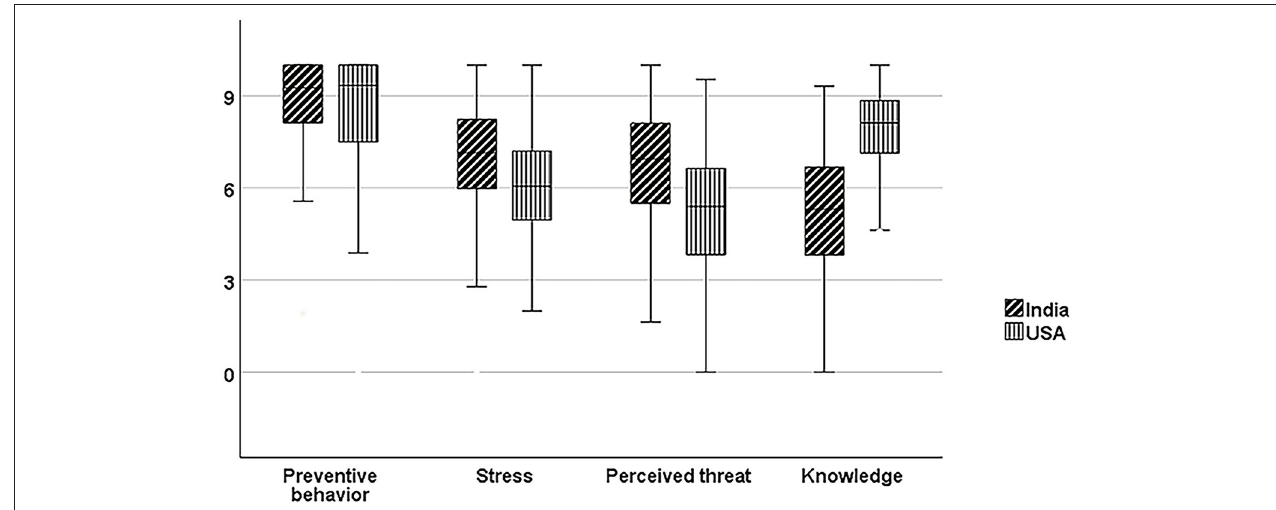
FIGURE 1 | Boxplots with error bars representing comparative scores of preventive behaviors, stress, perceived threat, and knowledge between the study participants of India and the USA. The scores are normalized on a “0–10 scale”, and the horizontal lines within the box represent the median value.